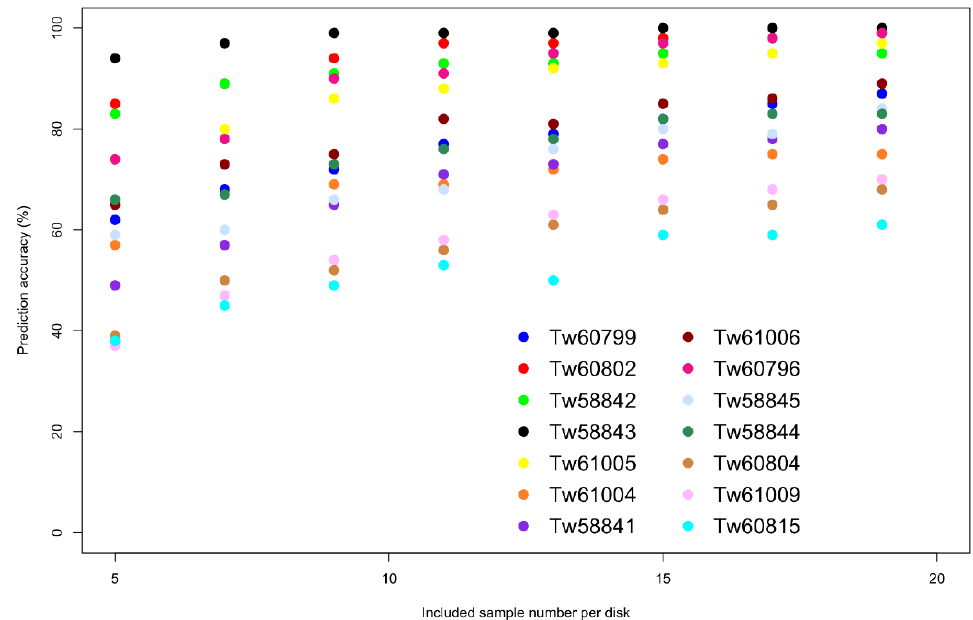
Figure 3. Average prediction accuracy for a random sample to be classified in the correct Terminalia superba disk through random forest with five-fold cross-validation and increasing sample number (from five to 19 samples, per two samples, with 100 runs per sample number). See Figure S2 in Supplementary Materials for individual graphs with standard deviation bars.